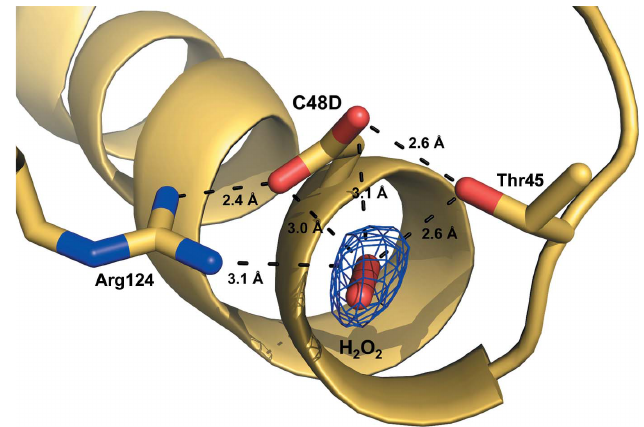
Figure 5 The H 2 O 2 binding site in H 2 O 2 -bound Prx3 (C48D/C73S) mimics the overoxidized structure. Bound H 2 O 2 and the residues involved are shown in stick representation at a resolution of 1.9 A˚ . Broken lines indicate the interactions between residues and H 2 O 2 . The ovoid-shaped electron density indicates H 2 O 2